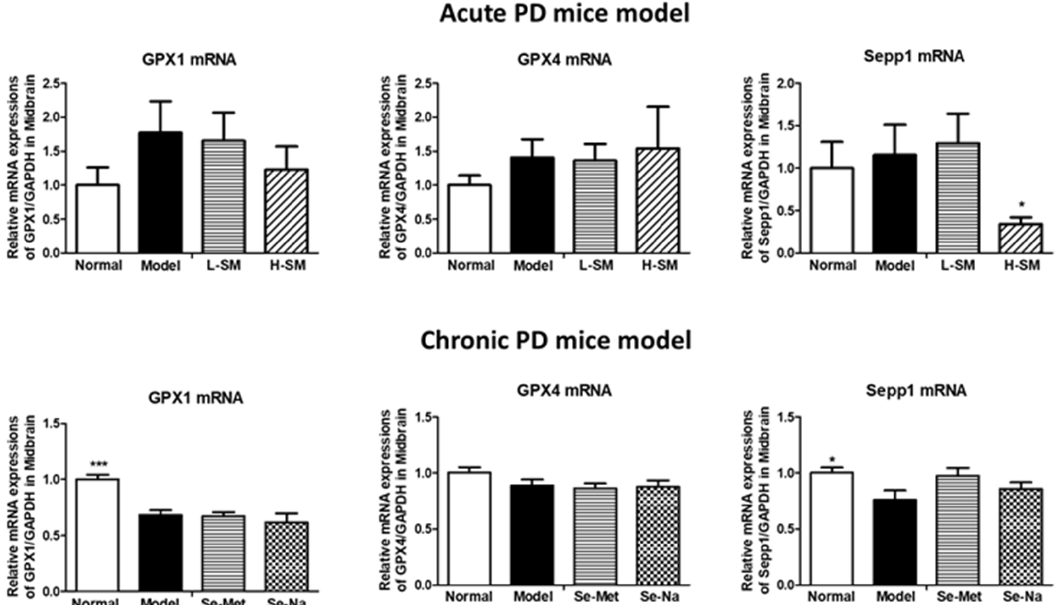
Figure 3. Comparative effects of Se ‐ Na and Se ‐ Met on gene transcripts of selenoproteins in the brain. mRNA expressions GPX1, GPX4, and Sepp1 in the midbrain of mice from both acute and chronic PD experiments. Levels of mRNA were shown as a quantitative ratio of the target gene to the GAPDH gene and relative to the group mean of the Normal group. Values are expressed as mean ± SEM, n = 6–8. * p < 0.05, *** p < 0.001 vs. Model group. Se ‐ Na, sodium selenite; Se ‐ Met, Seleno ‐ L ‐ methionine; GPX1, glutathione peroxidase 1; GPX4, glutathione peroxidase 4; Sepp1, selenoprotein